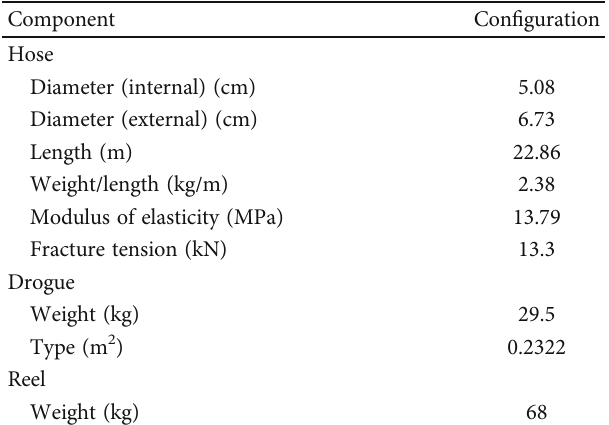
Table 2: Hose, drogue, and reel